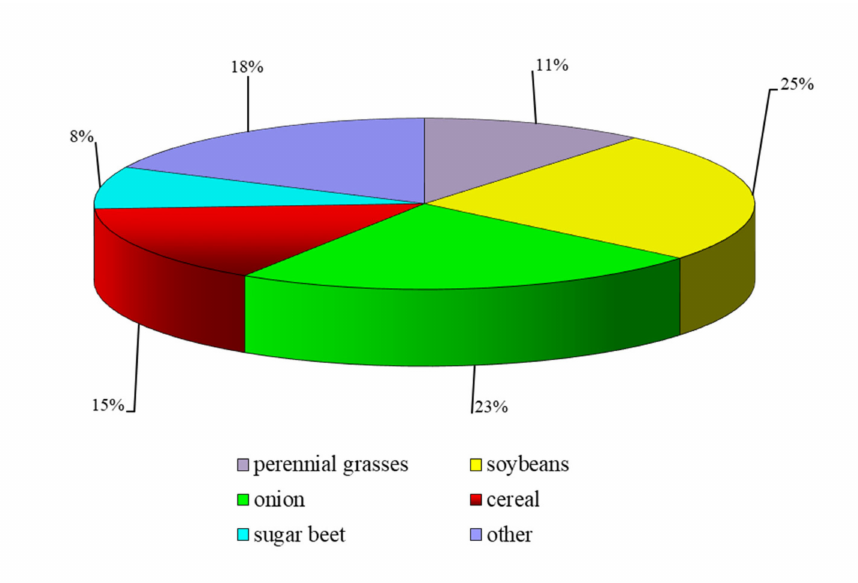
Figure 3. The structure of crop distribution in the Shengeldy irrigation area in